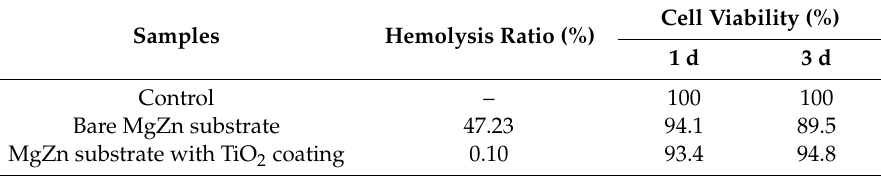
Table 1. List of the results of hemolysis and cytocompatibility tests.